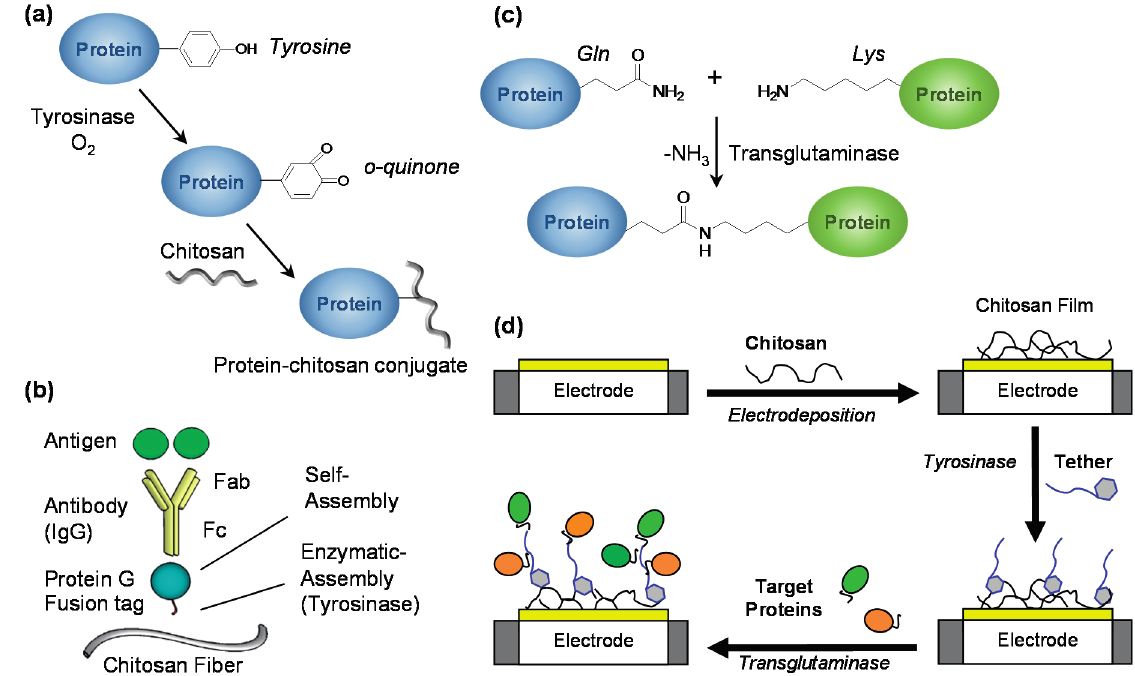
Figure 12. Enzymatic methods for assembling proteins to chitosan. ( a ) Tyrosinase oxidizes tyrosine to o -quinone residues that can react with chitosan; ( b ) Example of enzymatic assembly of a functional protein (IgG-binding protein) to chitosan.